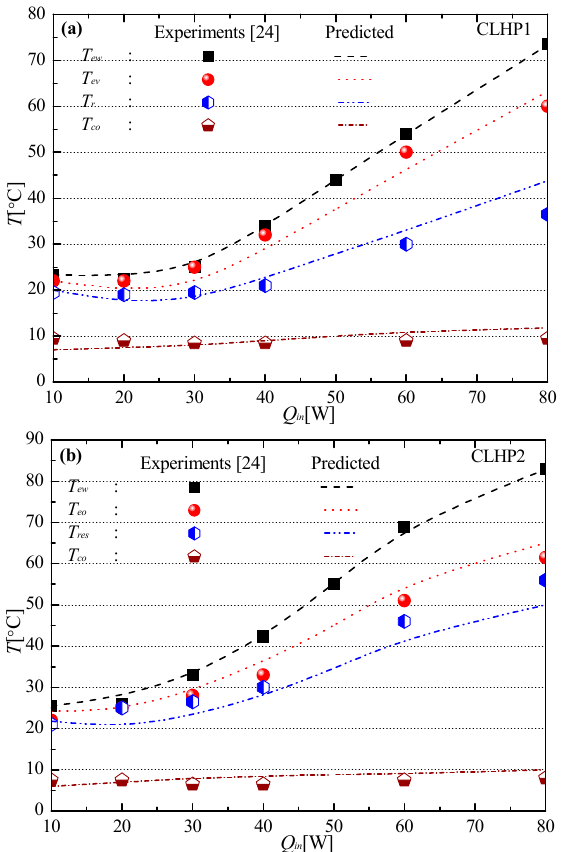
Figure 4. Comparison between temperature values reported in [24] and those obtained using the steady-state analytical model: ( a ) CLHP1; ( b ) CLHP2.